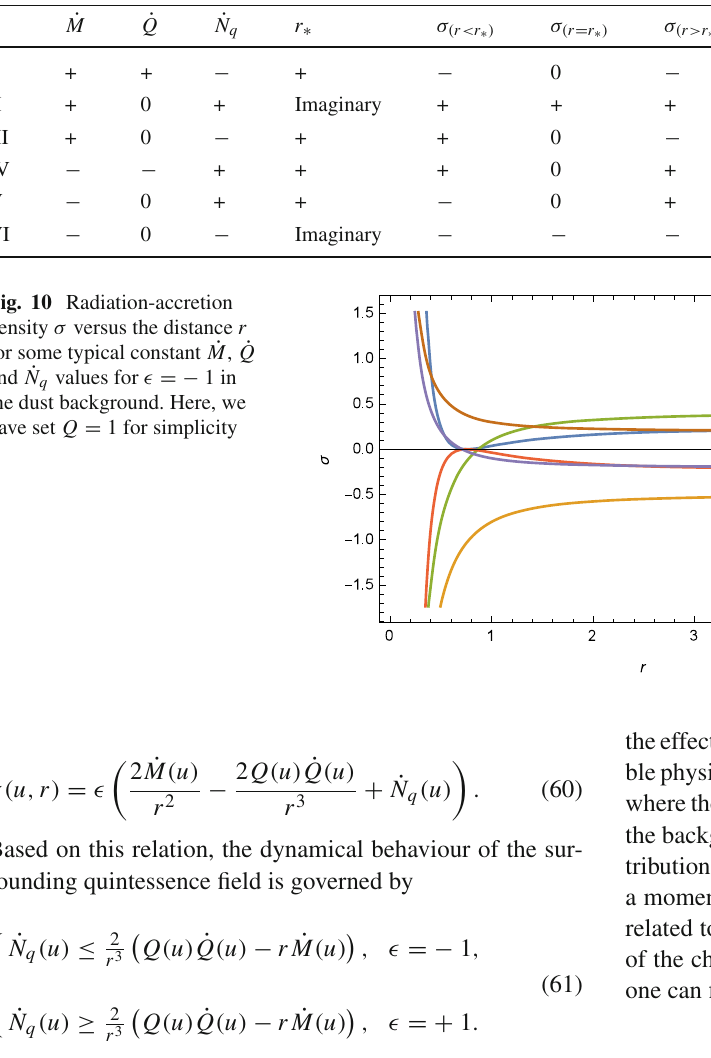
Table 6 General Bonnor–Vaidya BH and its quintessence SF parameters for (cid:2) = + 1